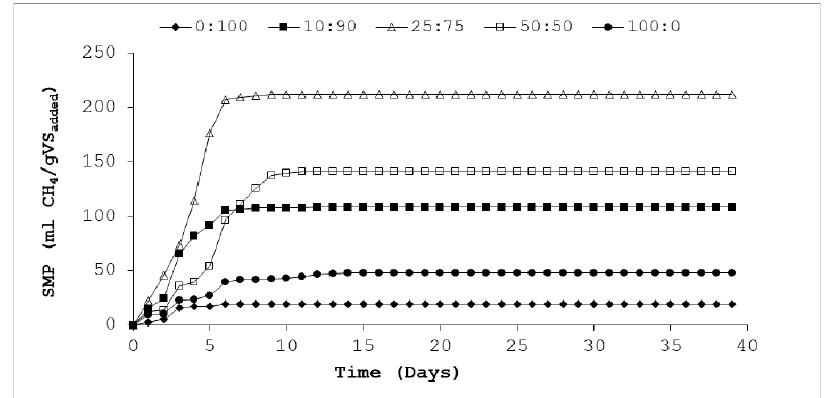
Figure 4. Specific accumulated methane production for the different mixtures tested.